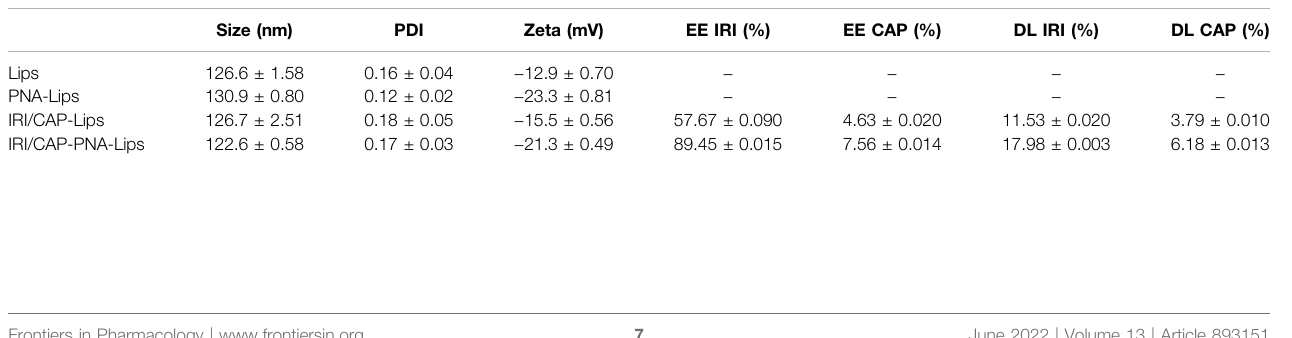
TABLE 2 | Characteristics of different types of liposomes (mean ± SD, n =